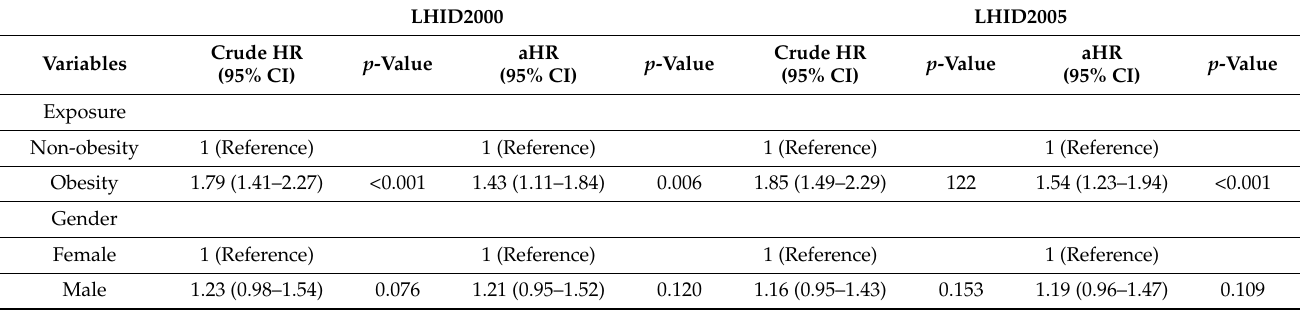
Figure 2. Cumulative incidence of open-angle glaucoma in obese and non-obese adults. ( A ) Cumulative incidence of OAG in the LHID2000; ( B ) cumulative incidence of OAG in the LHID2005; ( C ) age-stratified analysis for the cumulative incidence of OAG in the LHID2000; ( D ) age-stratified analysis for the cumulative incidence of OAG in the LHID2005. Both the LHID2000 and LHID2005 demonstrated that the cumulative incidence of OAG was higher in obese adults than non-obese adults (Log-rank test p < 0.001). In the age-stratified analysis, young obese adults (red line) displayed a remarkable cumulative incidence of OAG compared with young non-obese adults (red dotted line) (Log-rank test p < 0.001) although both the young and older obese adults had a significantly higher cumulative incidence of OAG. LHID = longitudinal health insurance database; OAG = open-angle glaucoma. Table 2. Multivariable cox proportional hazard regression of the association between open-angle glaucoma and potential risk